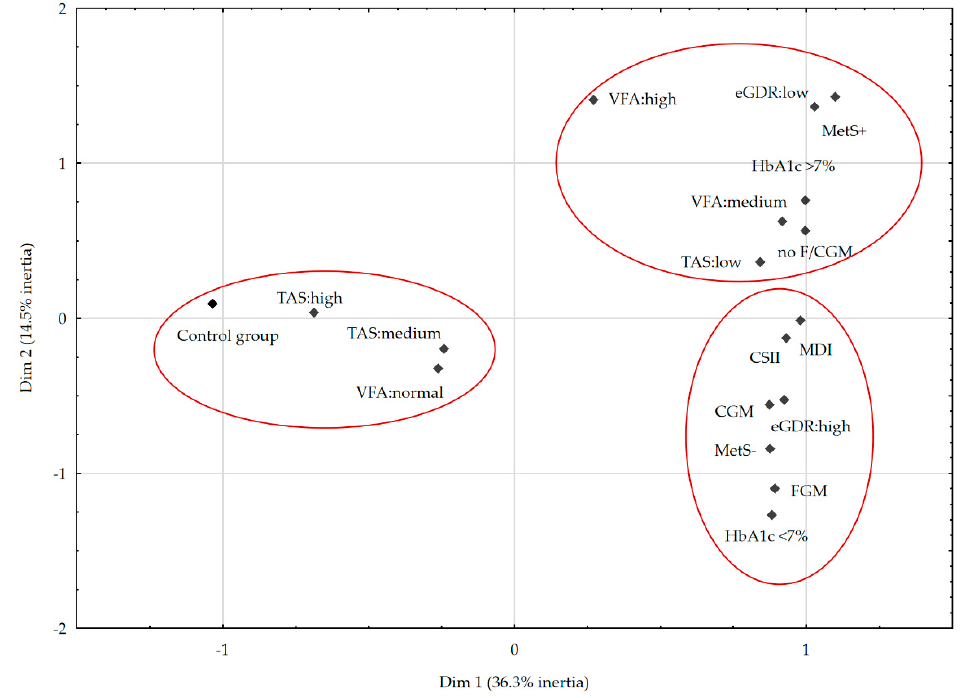
Figure 4. Multivariate correspondence analysis coordinate plot. Abbreviations: continuous glucose monitoring (CGM), continuous subcutaneous insulin infusion (CSII), dimension (dim), estimated glucose-disposal resistance (eGDR), flash glucose monitoring (FGM), glucose monitoring (GM), glycated hemoglobin (HbA1c), multiple daily injections (MDI), metabolic syndrome (MetS), total antioxidant status (TAS), visceral fat area (VFA).